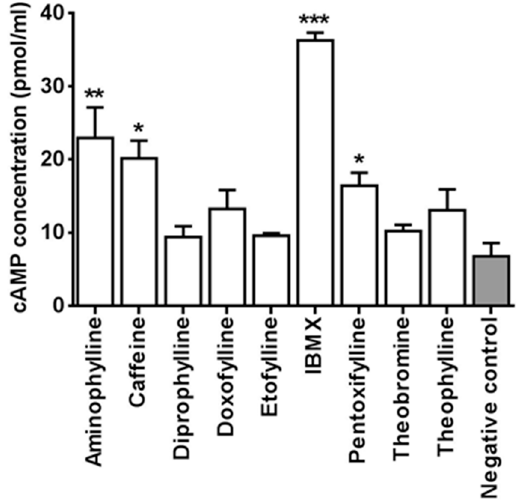
Figure 3. Cyclic AMP level in whole zebrafish embryos extract. The following doses of methylxanthine were used: aminophylline 500 mg/L, caffeine 150 mg/L, diprophylline 5000 mg/L, doxofylline 1000 mg/L, etofylline 600 mg/L, IBMX 50 mg/L, pentoxifylline 200 mg/L, theobromine 200 mg/L, and theophylline 200 mg/L. Negative controls were treated with dilution water without any drugs. Data are the mean ± S.D. of three independent experiments. Asterisks indicate statistically significant increase of cAMP compared to negative controls. Significance was determined using ordinary one-way ANOVA, followed by Dunnett’s multiple comparisons test. * p < 0.05; ** p < 0.005; *** p < 0.0001. White columns: methylxanthine treated embryos; grey column: negative controls.